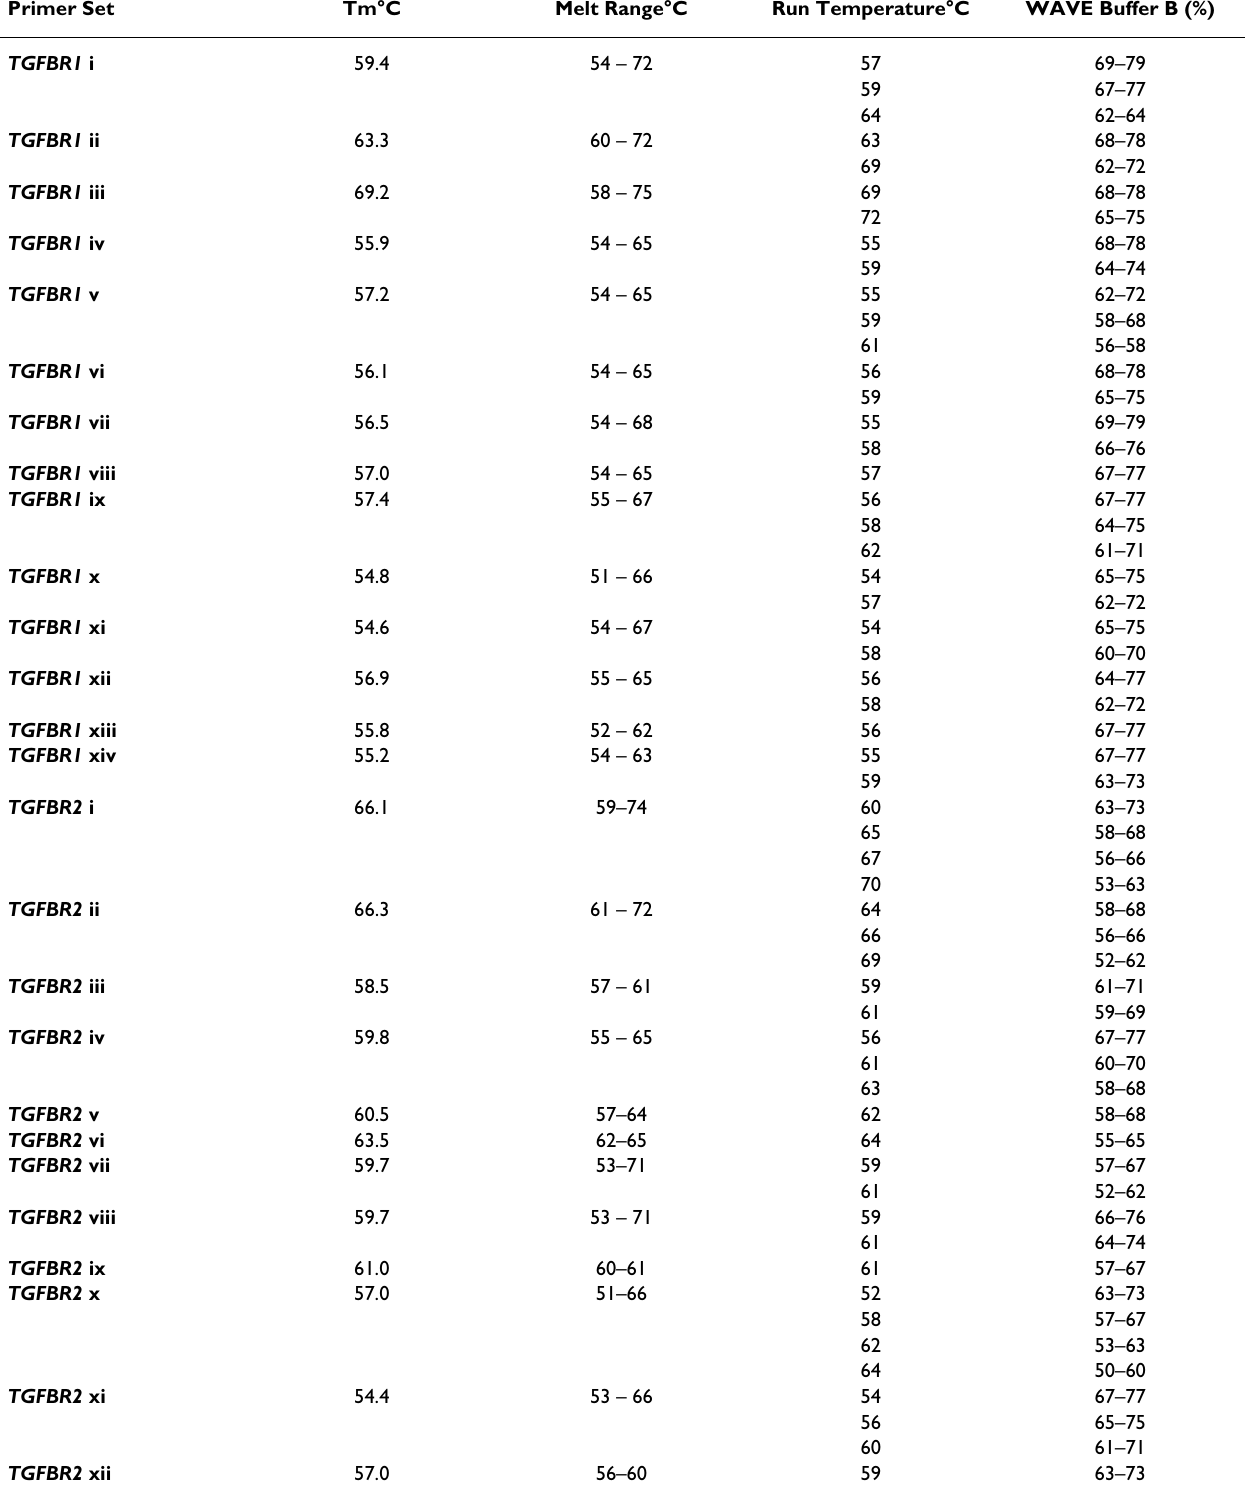
Table 3: WAVE conditions used for screening TGFBR1 and TGFBR2 genes. Primer